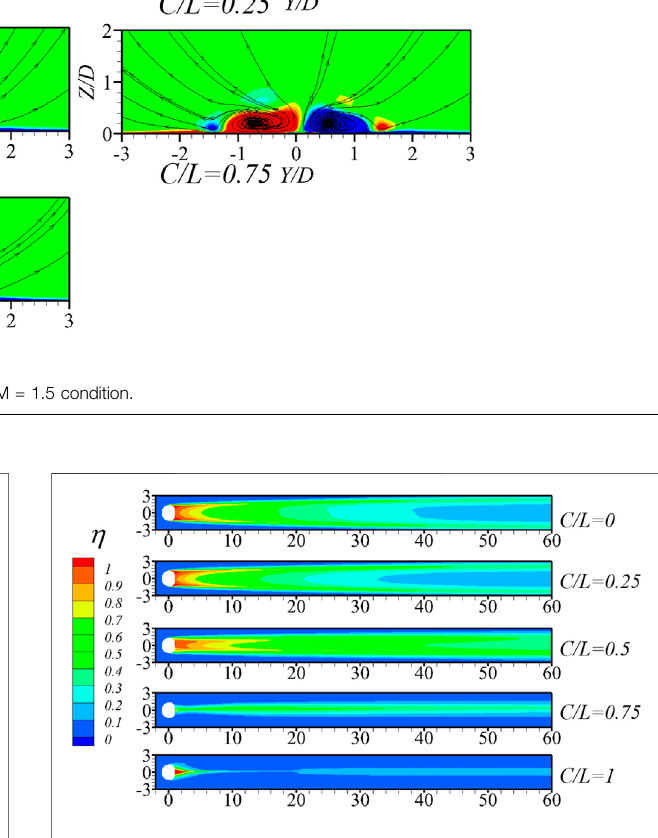
FIGURE 14 | Adiabatic cooling effectiveness contour in M (cid:2) 2.5